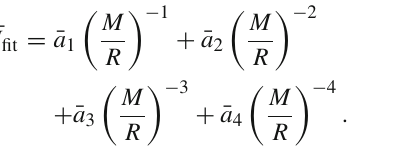
˜ I fit for β = − 0 . 01 of the monotonic ure 5 compares the fits coupling function (12), GR and the non-monotonic coupling function (11) at values β = − 0 . 08 and β = 0 . 08. These fits are obtained using an equal number of points for each of the 6 EOS (APR4, SLy, MS1, MPA1, APR2 and H4) and fitting the functional form (28) through least squares. In Table 1 the numerical values of the fitting coefficients, as well as the fitting error, for some representative combinations of the parameters are displayed.